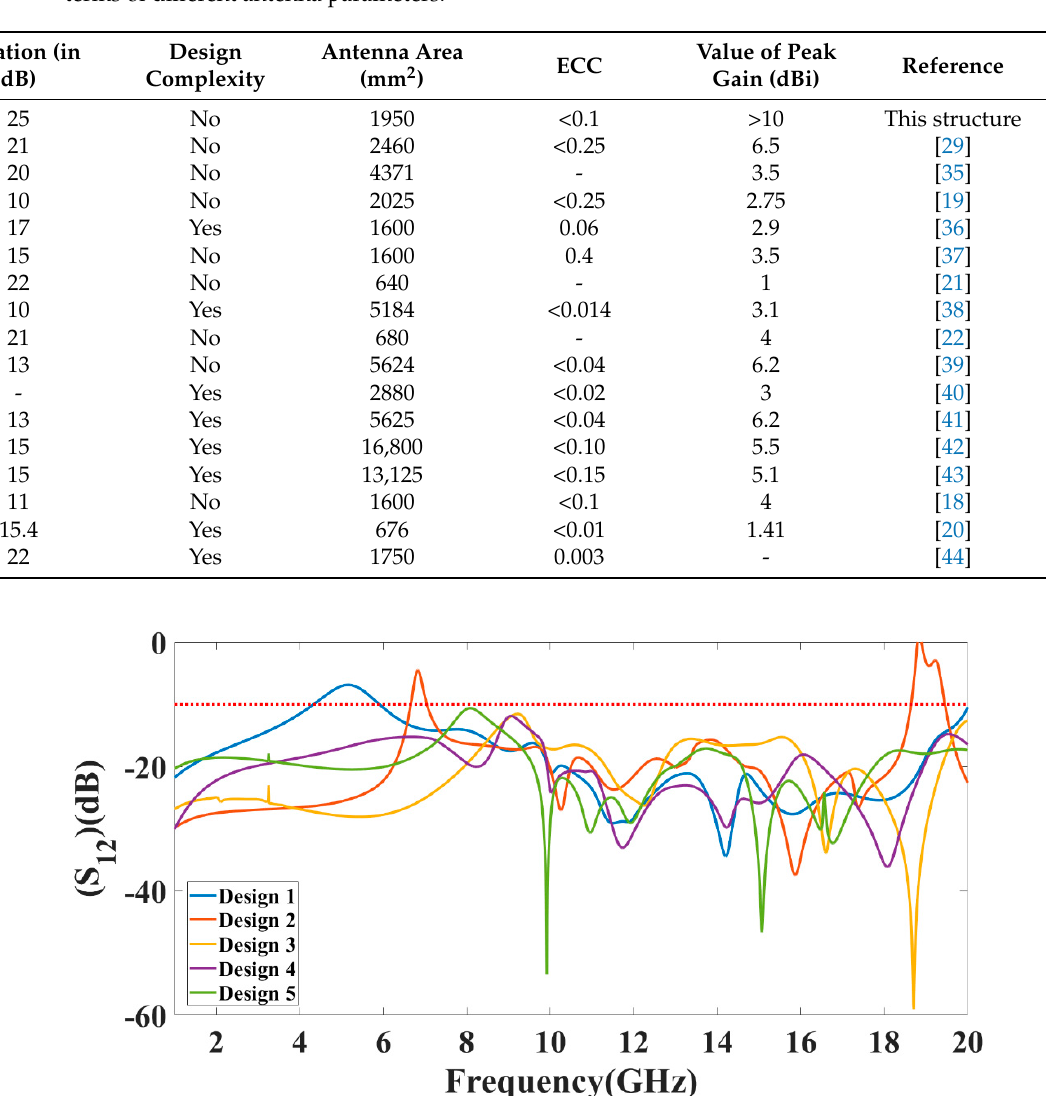
Table 5. Comparative analysis of the proposed MIMO antenna with previously published results in terms of different antenna parameters.